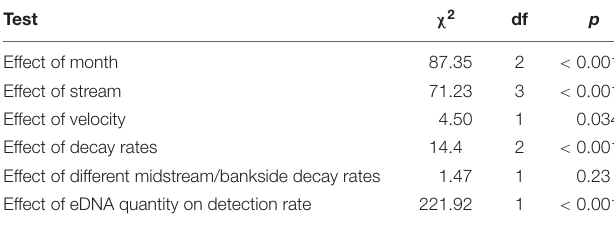
TABLE 3 | Likelihood ratio tests for model